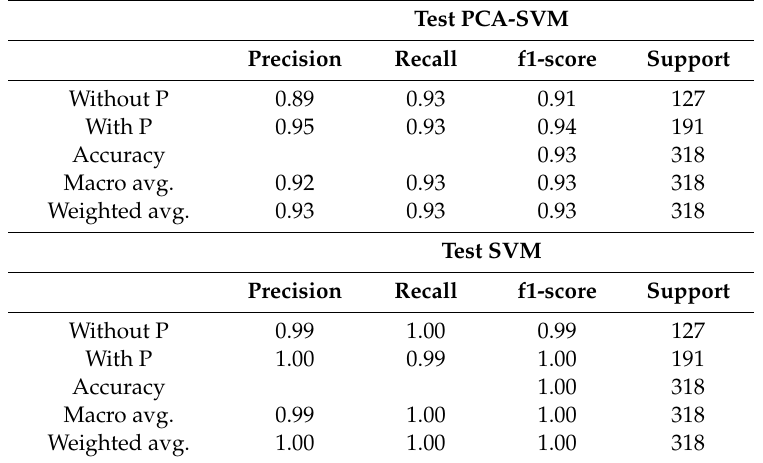
Table 3. Parameters for the external evaluation for each support vector machine (SVM) model.